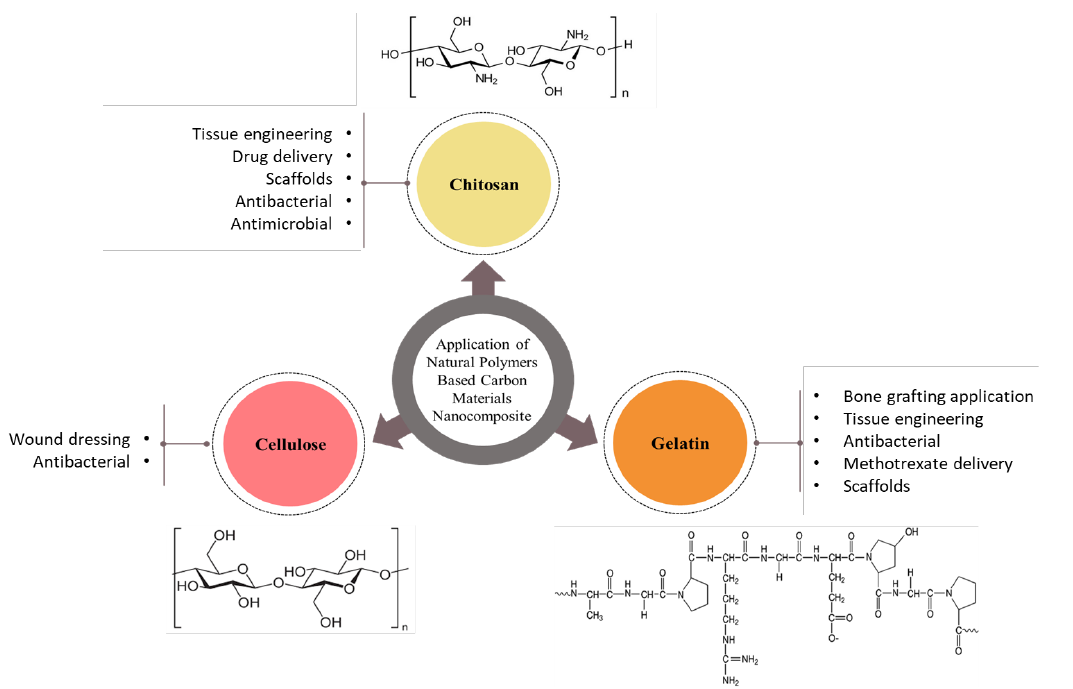
Figure 1. Schematic illustration of the most common natural biopolymers for biomedical applica-